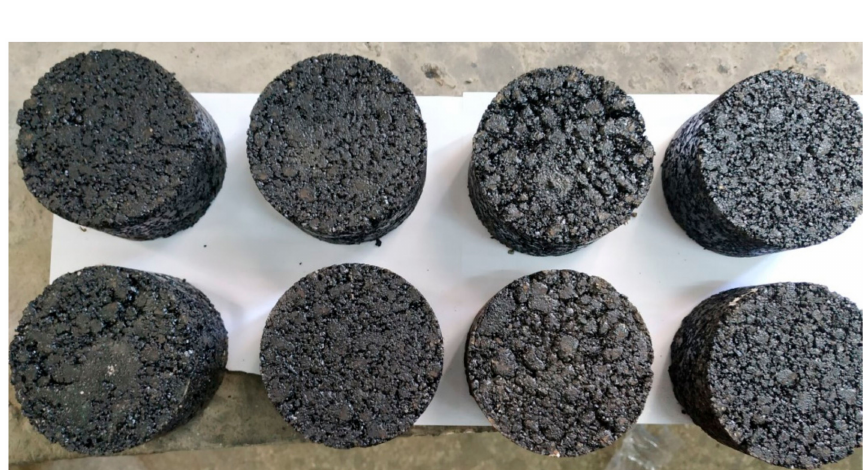
Figure 4. Marshall